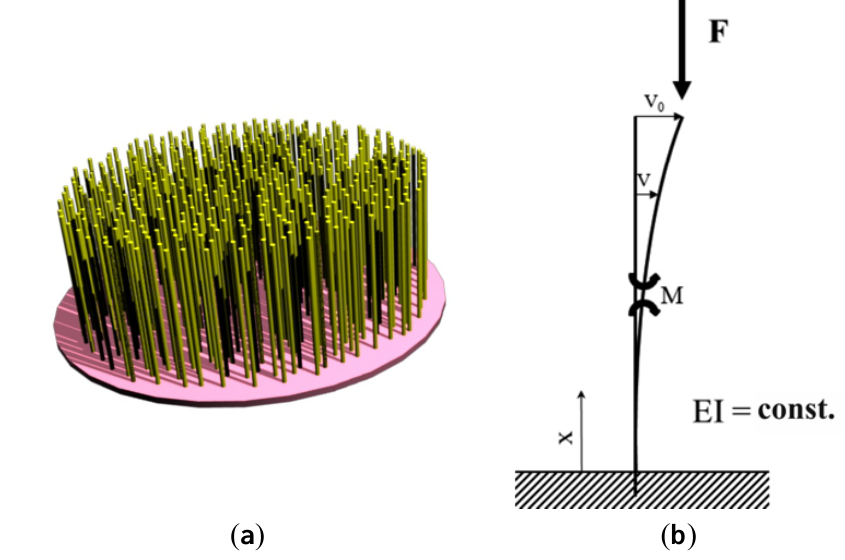
Figure 4. Model of the flock scaffold. ( a ) Theoretically optimal model of the flock scaffold; ( b ) Balance of forces on the fiber (according to